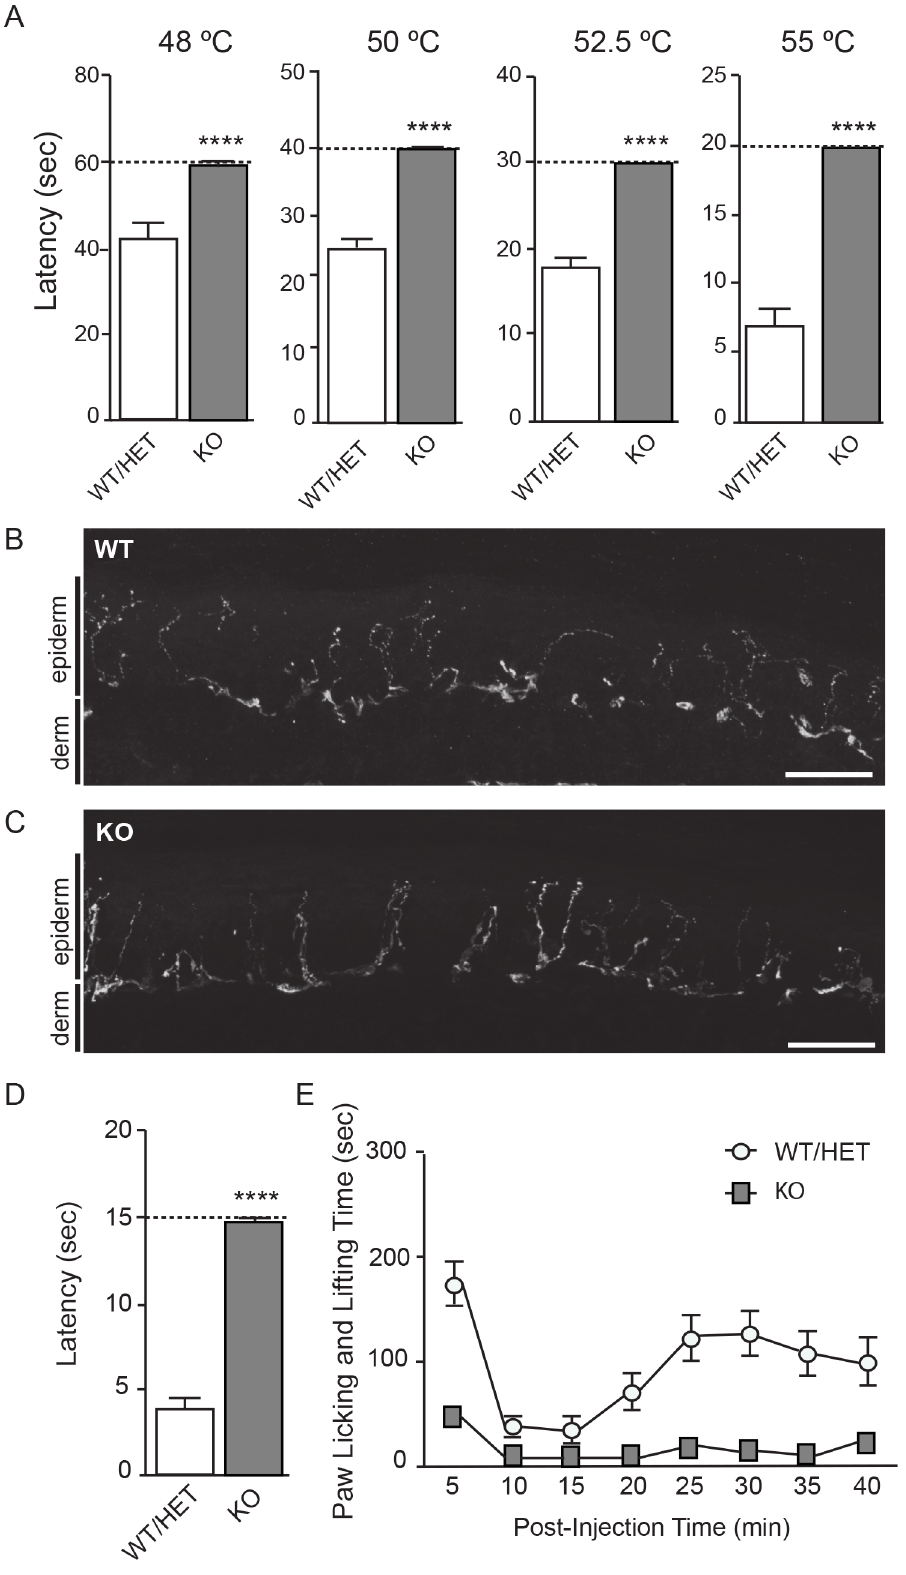
Figure 4. Nav1.7 KOs are insensitive to painful thermal, mechanical, and chemical stimuli. A. Latency of paw withdrawal in hot plate testing from Nav1.7 KOs (n=18) and WT/HET littermates (n=20). Withdrawal latency was tested at temperatures ranging from 48 u C to 55 u C as noted atop each panel. For WT/HET animals, withdrawal latency decreased with increasing temperature (note different y-axis scale for each panel). At each